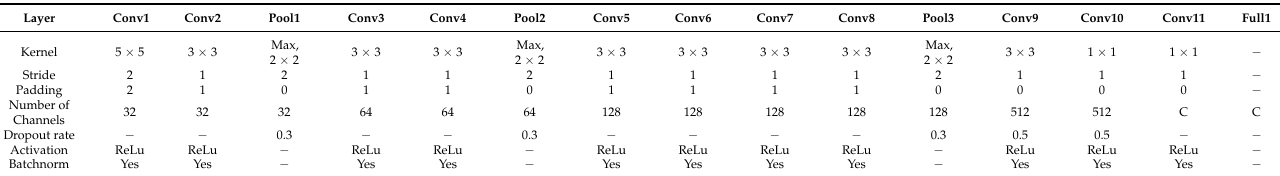
Table 1. Architecture of the proposed CNN